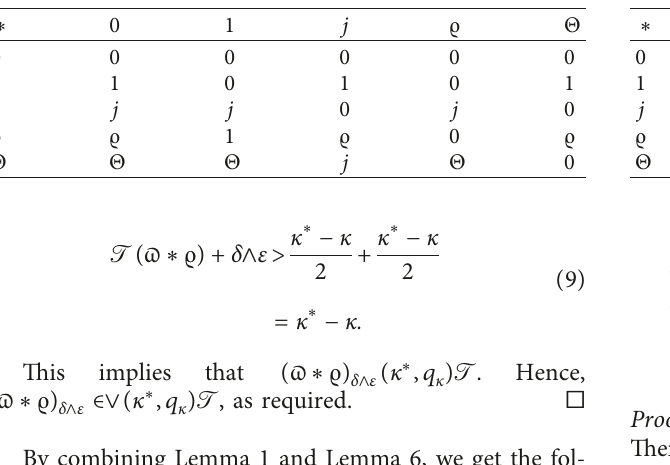
Table 5: Cayley table of the binary operation ∗ . Table 6: Cayley table of the binary operation ∗